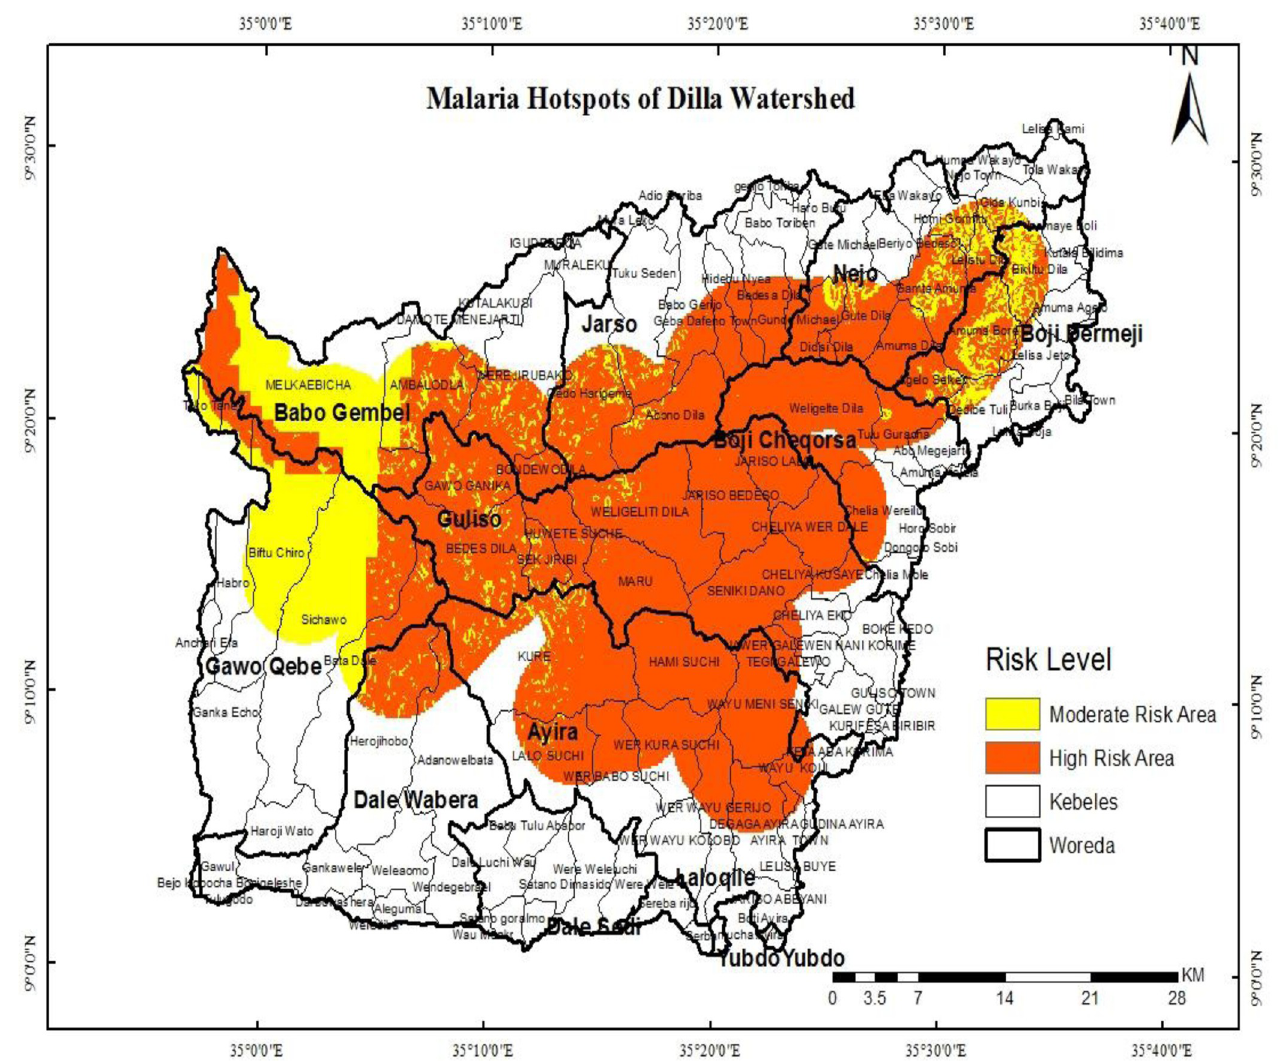
Fig 5. Malaria risk map of Dilla watershed. Source: Ethiopian Central Statistical